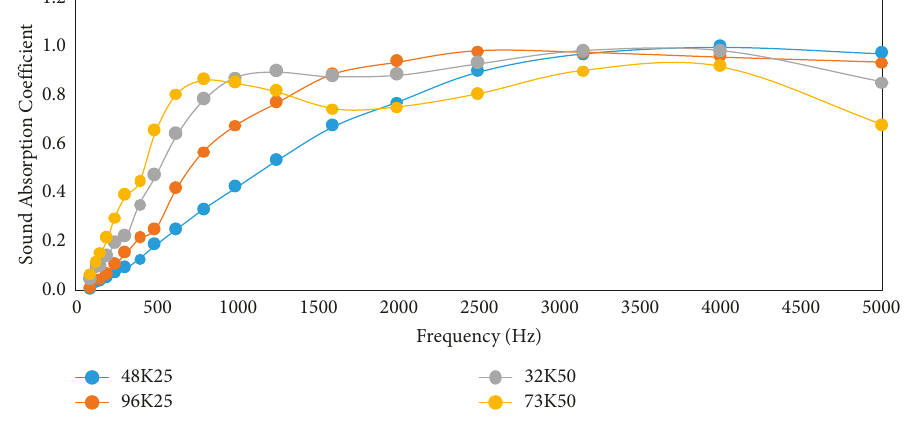
Figure 7: SAC of the impedance rube method.